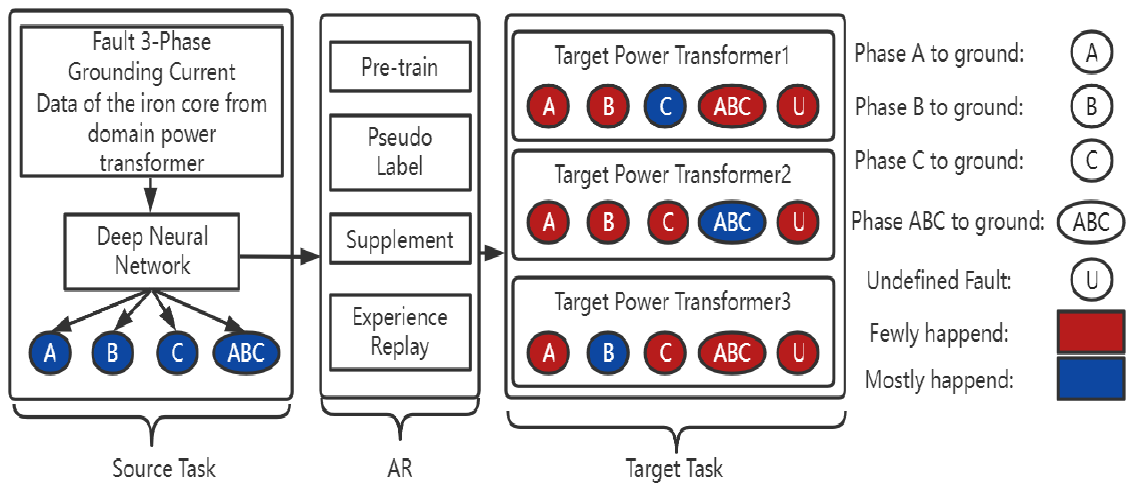
Figure 1. Methodology of the whole